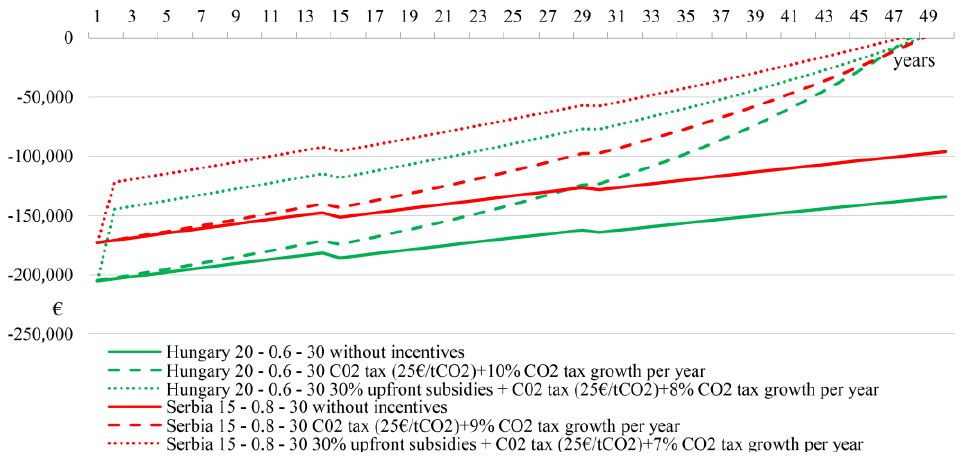
Figure 11. The combination of the incentives that could result in an NPV cost-effective period of 50 years (d = 3.5%, energy price rise 3% per year) for the optimal NG scenarios for Hungary and Serbia.